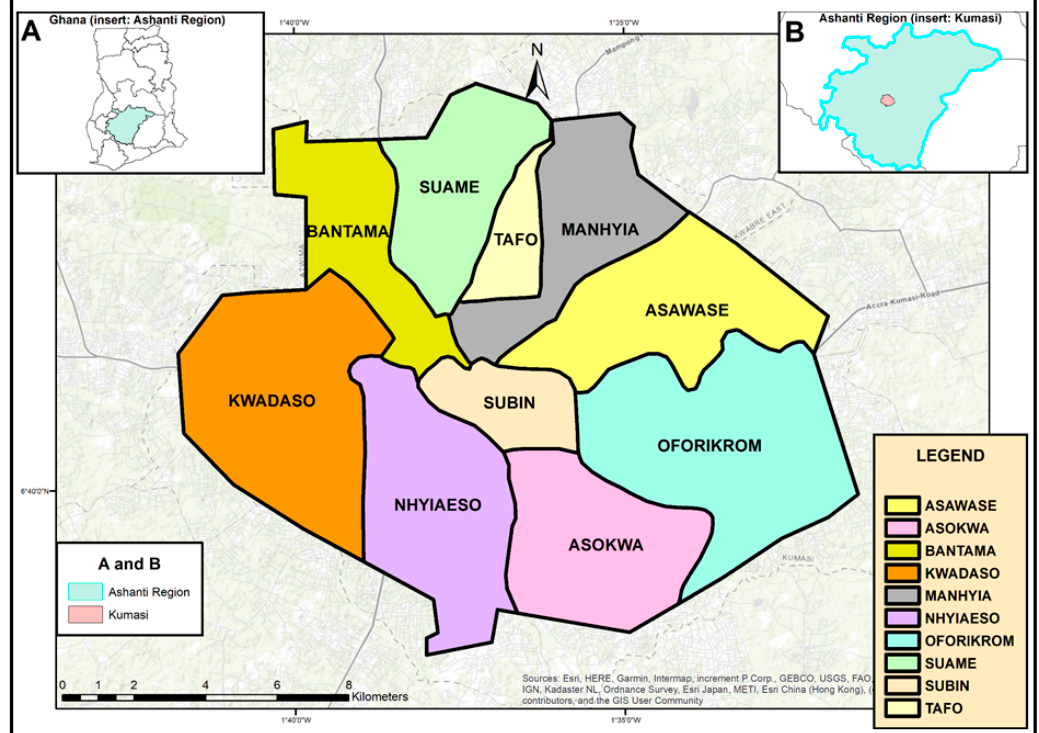
Figure 1. Study Area: Kumasi Metropolis with its sub-metropolitan divisions. Landsat TM/OLI satellite images were obtained based on availability, suitability, spatial and temporal resolutions as shown in Table 1. The selected images were cloud-free and of the dry season. This explained the differences in the time step of the satellite images utilized in our study. The timespan ranged from 1986 to